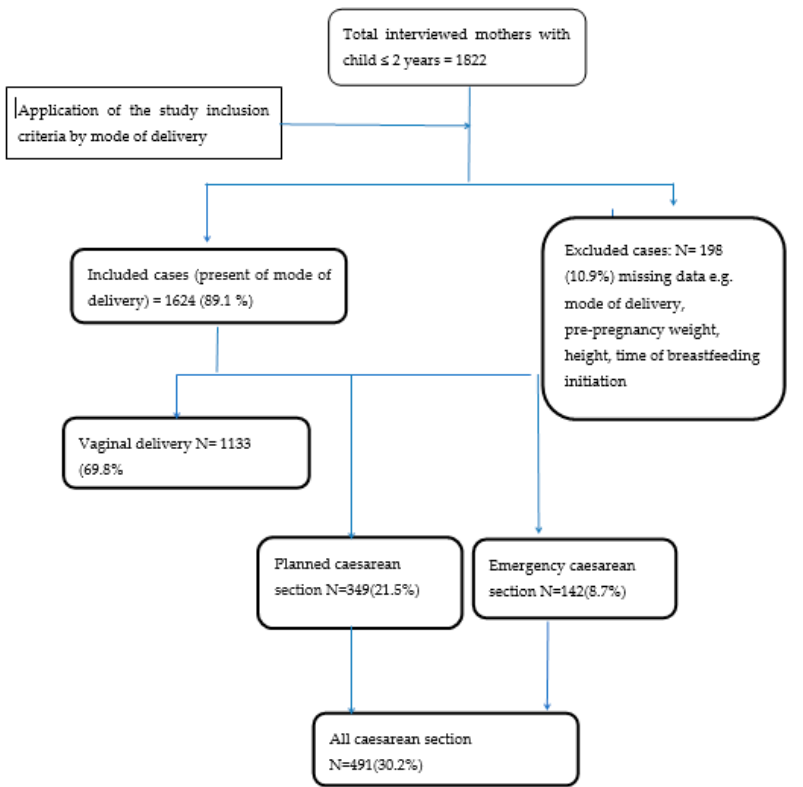
Figure 1. Study participants flow chart and main findings.